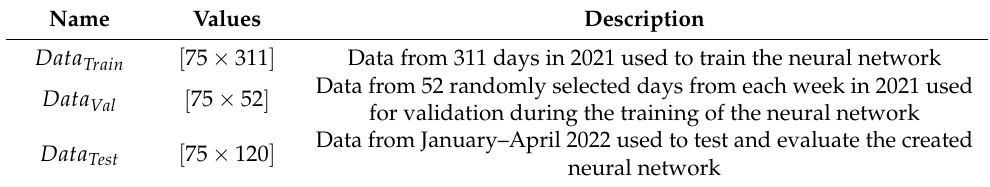
Table 4. Training, validation, and testing data used for the neural